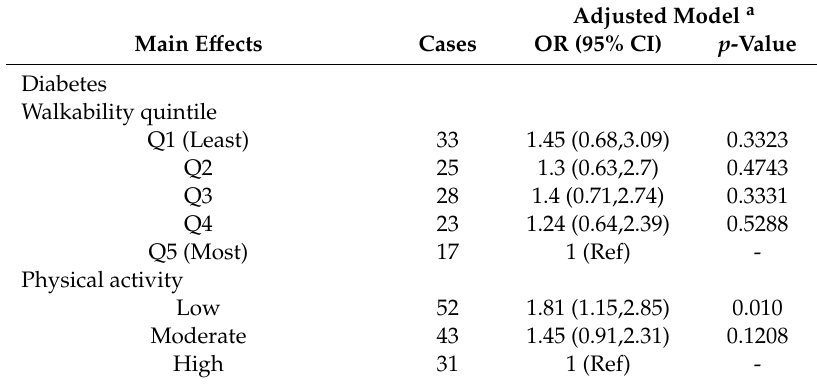
Table 4. Associations of walkability and physical activity with selected chronic conditions and multi-morbidity at